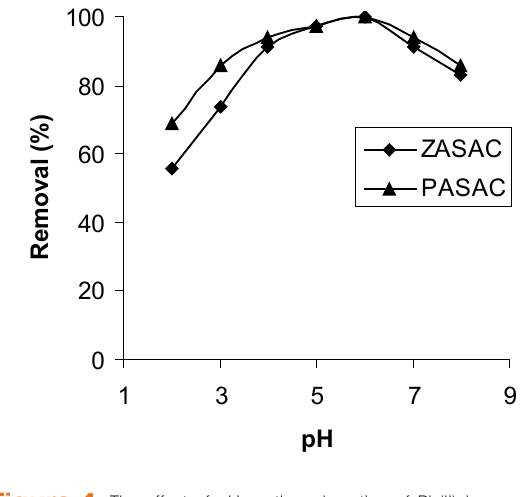
Figure 4. The effect of pH on the adsorption of Pb(II) ions onto (a) PASAC and (b) ZASAC. Conditions: 50 mL Pb(II)